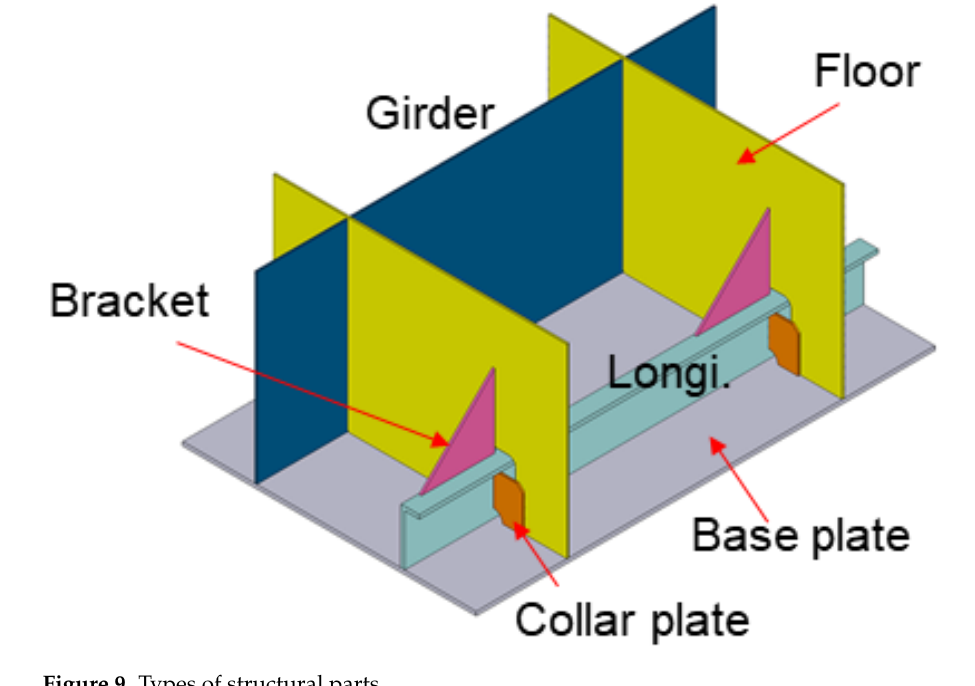
Figure 9. Types of structural parts.